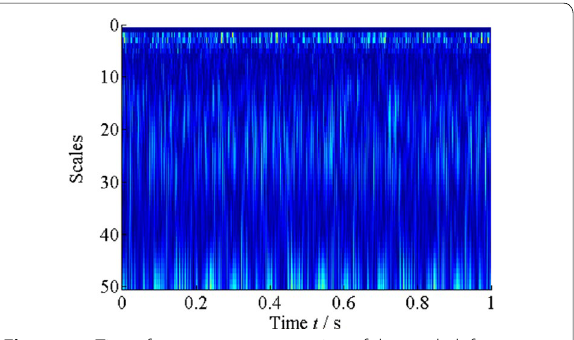
Figure 17 Time–frequency representation of the crack